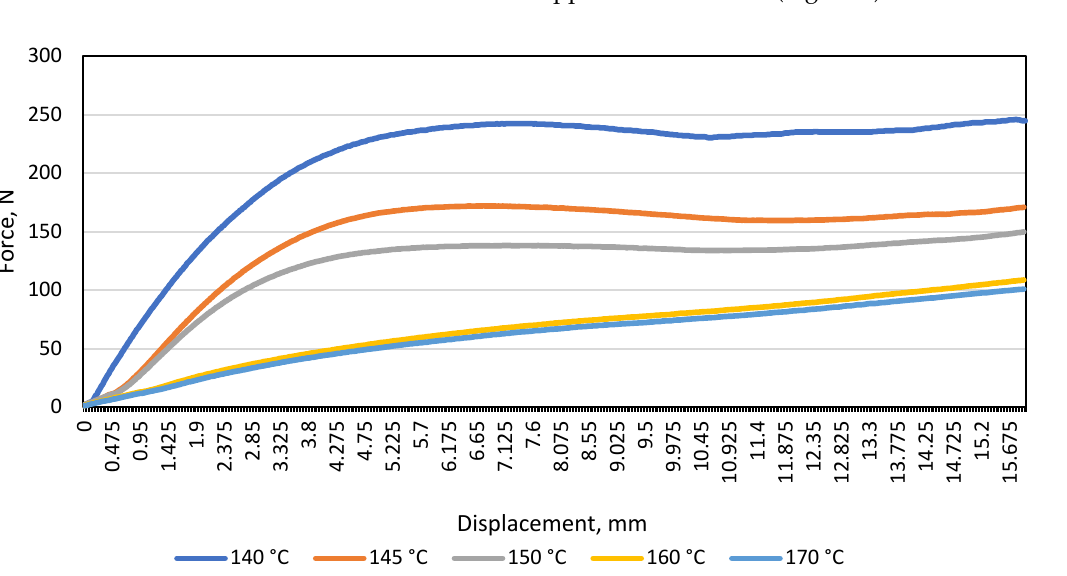
Figure 4. Diagram of the load and displacement of the material B during bending at different temperatures when the distance between the supports was 80 mm.